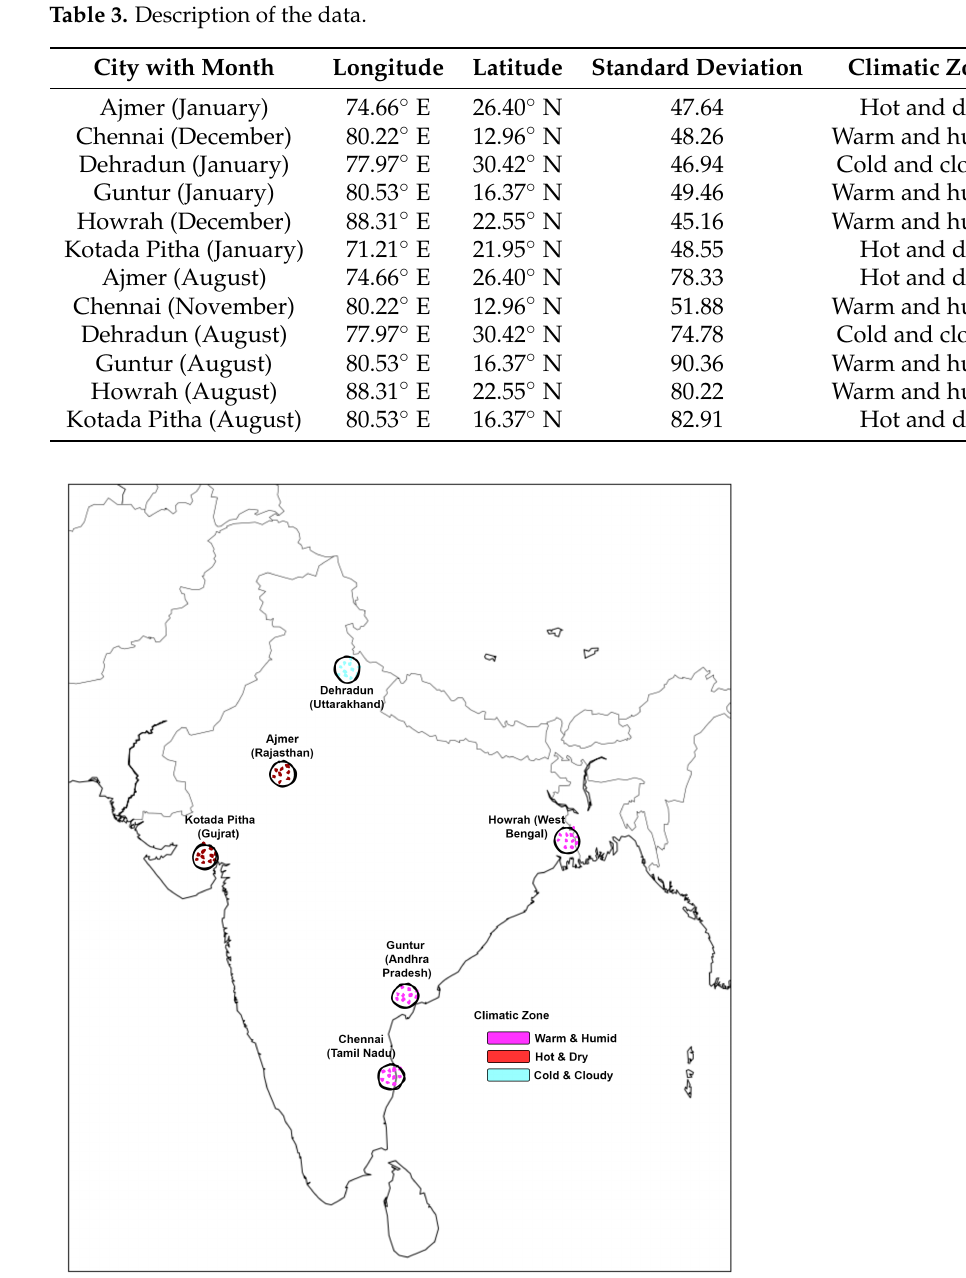
Figure 4. Solar stations based on climatic